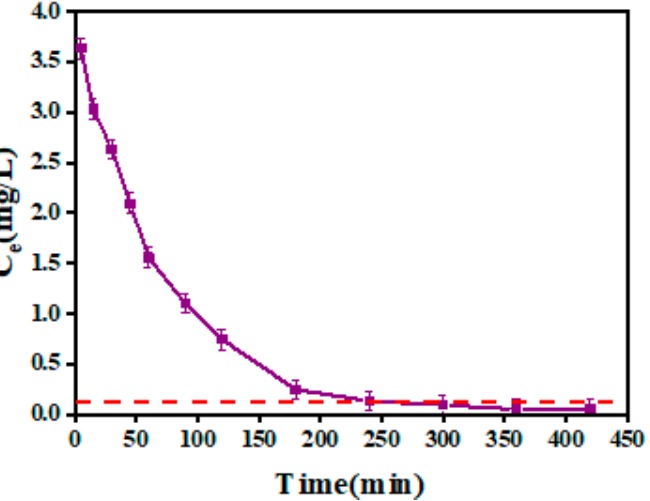
Figure 8. Application of CTAB@FZA for chromium removal from industrial wastewater. The dashed red line indicates the USEPA surface water permissible standard (pH = 3, dose = 0.5 g/L, T = 298 K).